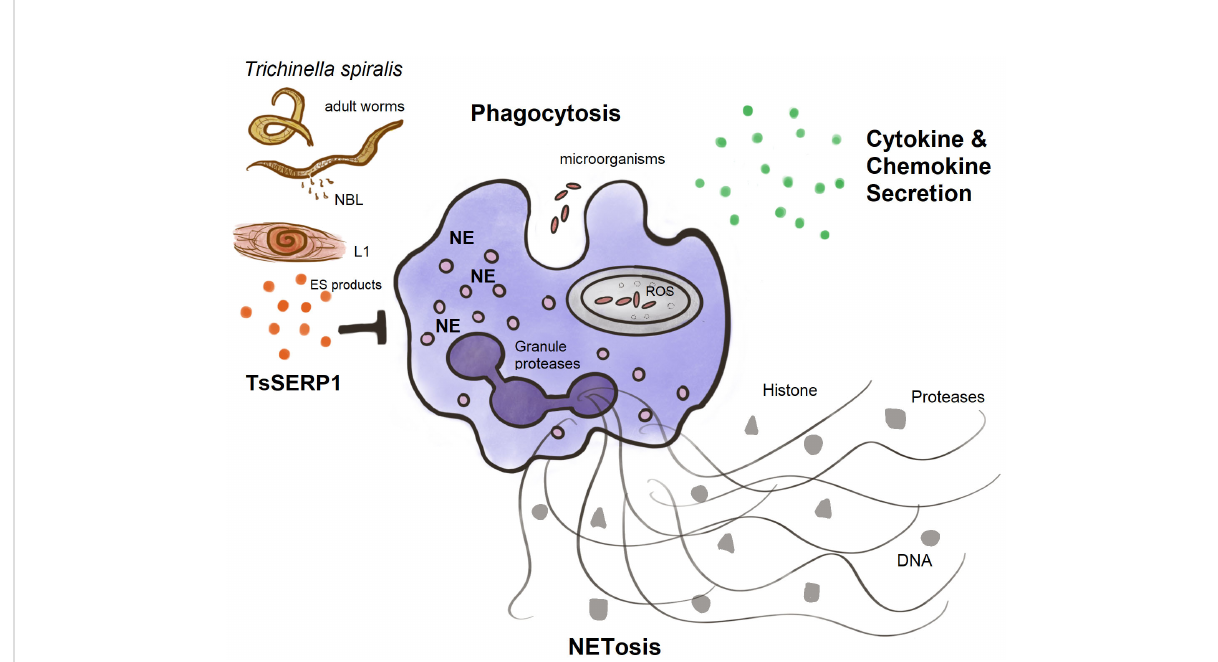
FIGURE 7 A diagram summarizing the main fi ndings of this study. TsSERP1, presented at different developmental stages of T. spiralis and its excretory- secretory (ES) products, inhibited the hNE activity of human neutrophils. The inhibitory effect of TsSERP1 on hNE in fl uences neutrophil functions by impairing phagocytosis, NETosis, and the production of proin fl ammatory cytokines and